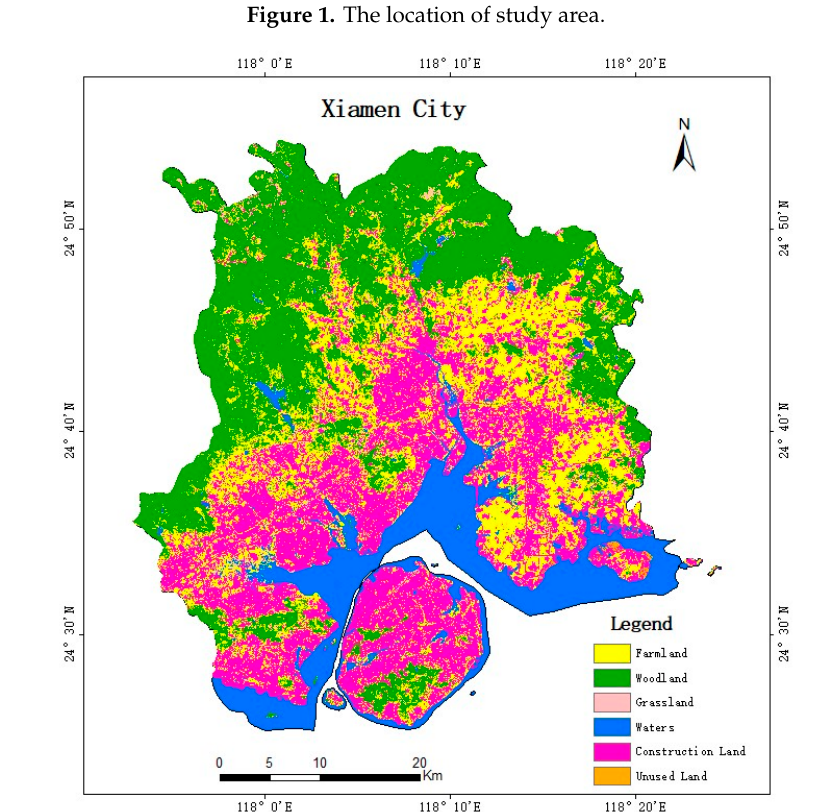
Figure 2. Land use status of Xiamen in 2017.